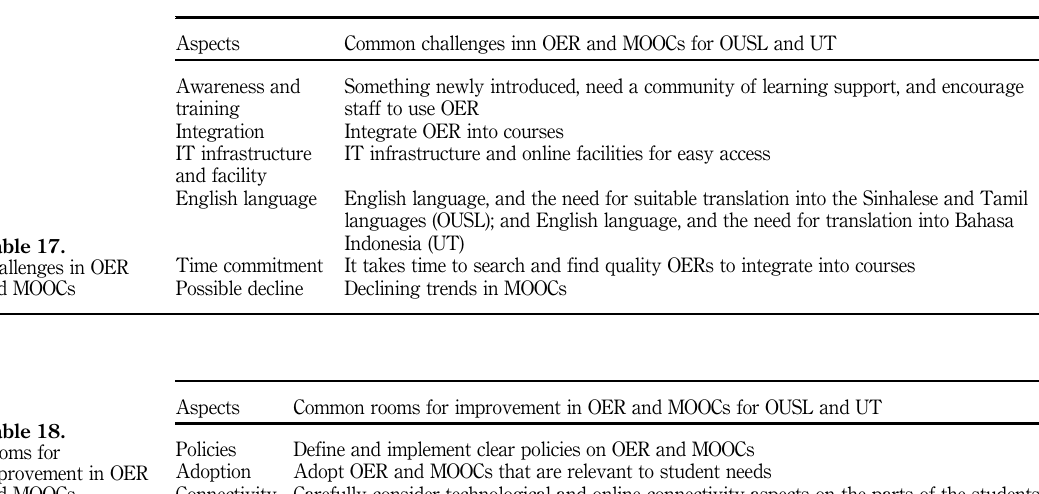
improvement in OER and